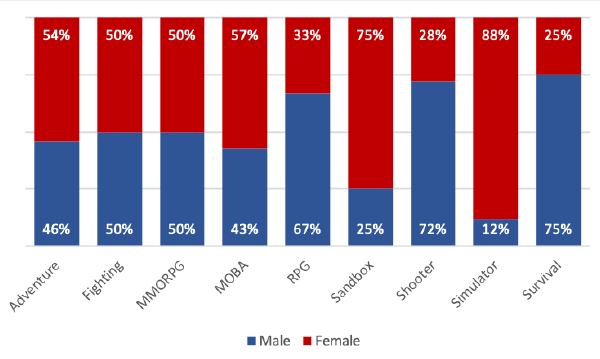
Figure 8. Game genres by